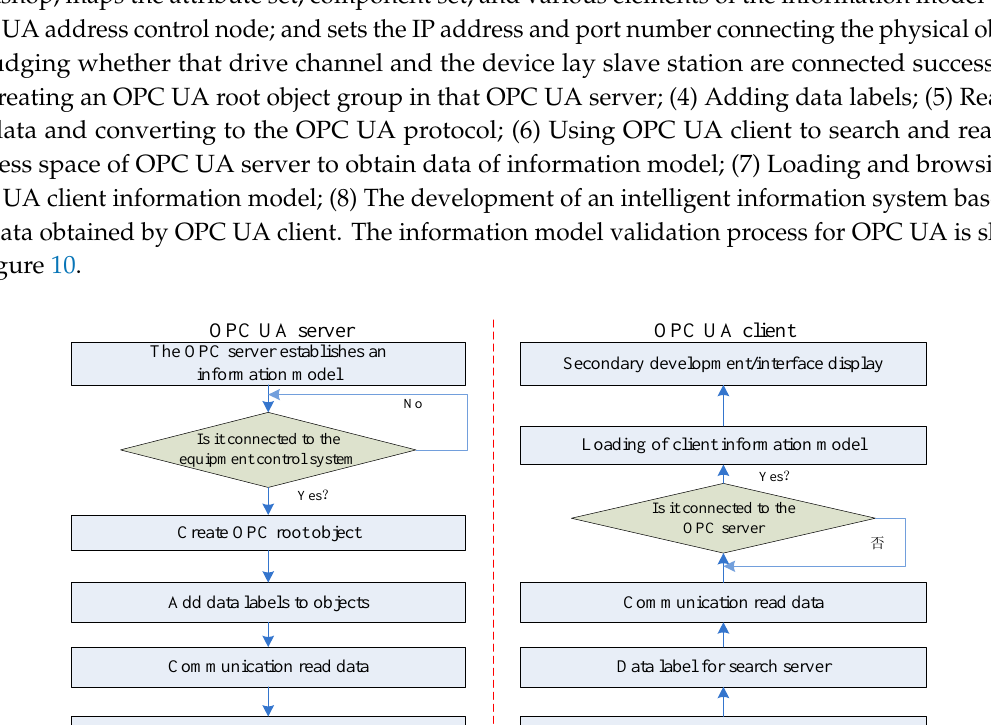
Figure 9. Architecture of OPC UA server/client in lithium ion battery intelligent manufacturing workshop.